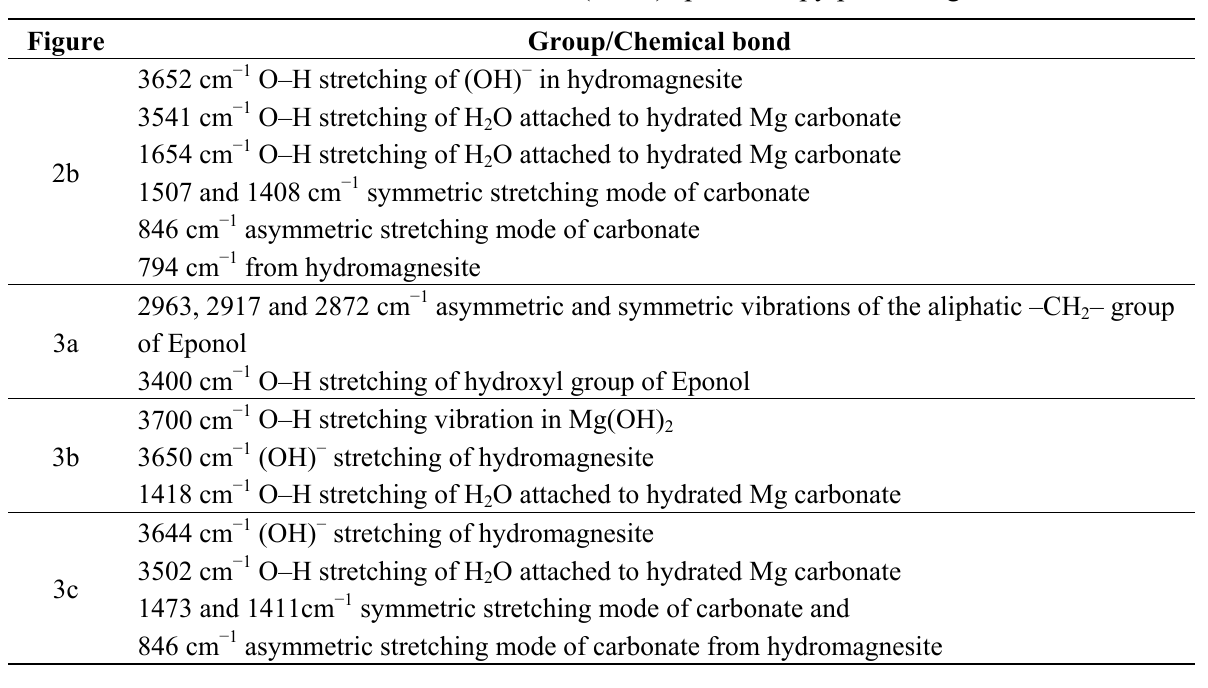
Figure 3. FTIR spectra of MgPUnt coated AA2024-T3 at ambient ( a ), after exposure at Daytona beach for 7 days ( b ) and 30 days ( c ); and at the rain forest site and marine exposure in Hawaii ( d